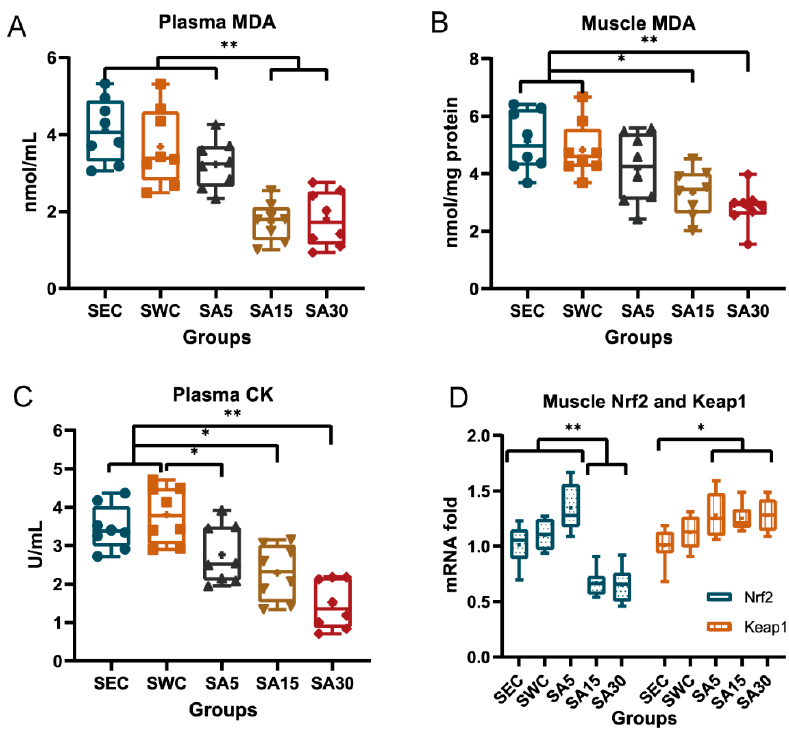
Figure 3. E ff ects of astaxanthin on the MDA level, CK activity, and Nrf2-Keap1 factors’ transcriptional level in swimming training mice. ( A ) and ( B ) show the amount of MDA in plasma and muscle among di ff erent groups, respectively. ( C ) represents CK activity in plasma among di ff erent groups. ( D ) outlines transcriptional levels of Nrf2 and Keap1 factors among di ff erent groups, in which the fold changes are expressed in relation to the mean of the SEC group. Values are expressed as Box-and-Whisker plots, in which the bottom and top of the box present the first and third quartile, respectively; the band inside the box is always the second quartile (the median); lines extending vertically from the boxes (whiskers) stand for the upper and lower extreme (the highest and lowest number in a set of data), and plus signs indicate the mean for each group. The symbol * indicates a significant di ff erence at p < 0.05, and ** indicates a significant di ff erence at p < 0.01.